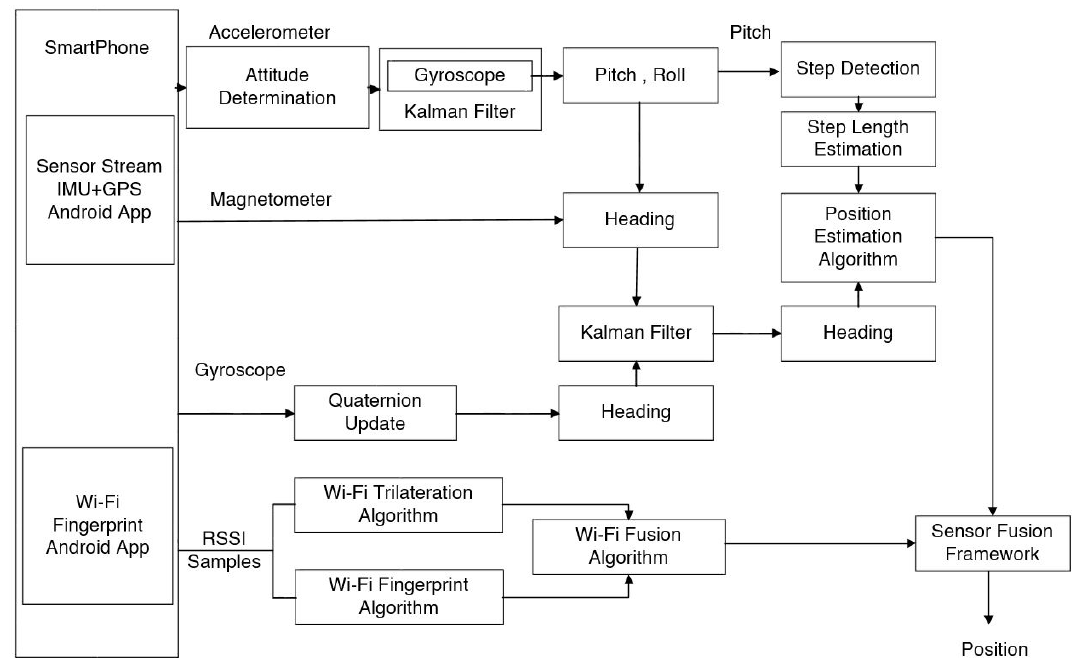
Figure 1. Proposed sensor fusion framework for PDR and